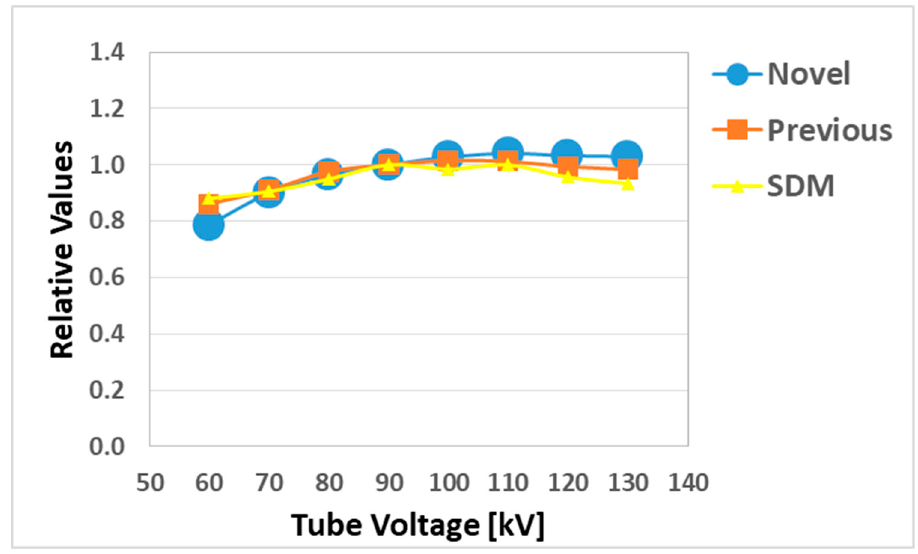
Figure 5. Energy (tube voltage) dependence compared with the novel, previous sensors and skin dose monitors (SDM).